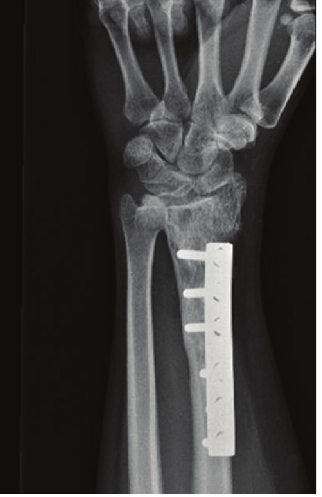
Figure 2: Anteroposterior radiograph of an APC of the proximal humerus showing adequate union of the junction.